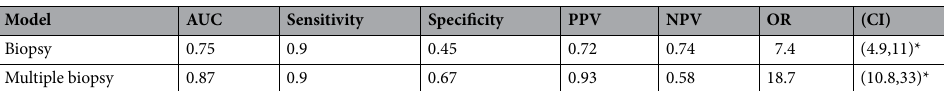
Table 2. Diagnostic performance in BPH/LUTS patients undergoing a biopsy or multiple biopsies. Diagnostic performance (AUC), sensitivity, specificity, positive predictive value (PPV) and negative predictive value (NPV), odds ratio (OR), and 95% confidence interval (CI) of the OR for each model. * p < 0.05 in discrimination